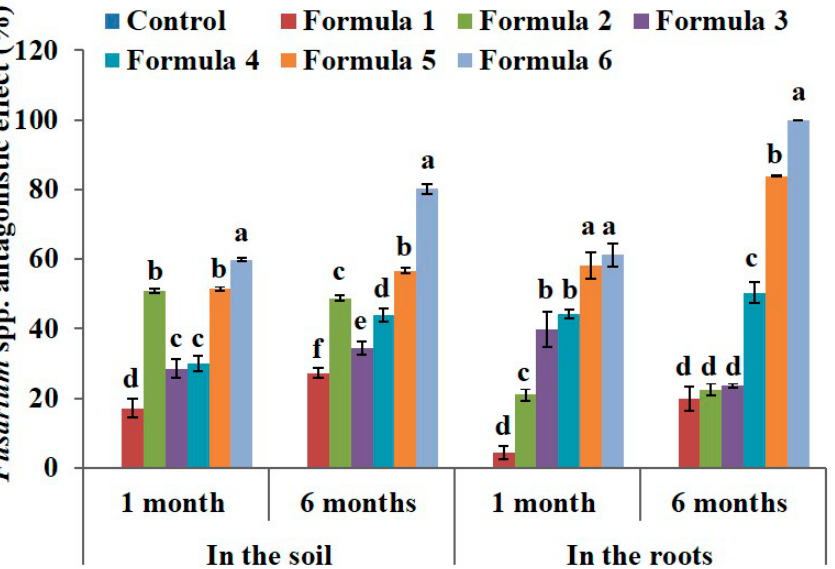
Figure 3. The effect of bio-products on Fusarium spp. in the soil and in the roots at the black pepper farm after 1 month and 6 months of treatment. The experiment was designed 7 formulas involve control formula and six treated formulas as mentioned in Table 2. Data represent mean and error bars from three different replicates; each replicate contained at least 30 individual black pepper stumps per treatment. All statistical analyses including one-way variance analysis (ANOVA) and Duncan’s multi range test were carried out using Statistical Analysis Software (SAS 9.4). Different letters indicate statistically significant differences among the values of formulas analyzed after 1 month or 6 months ( p < 0.05). By using the Henderson–Tilton formula to calculate the antagonistic effect, mean of control formula is always zero value.